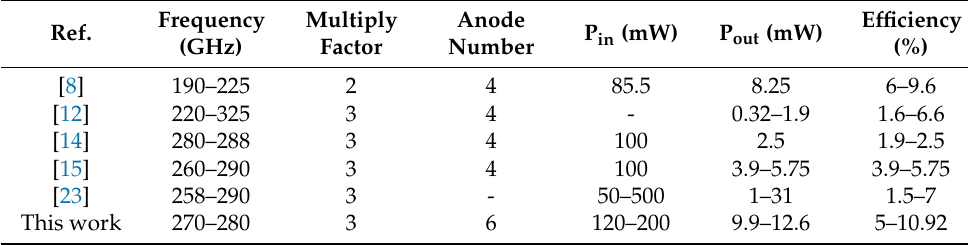
Table 2. Comparison of reported frequency